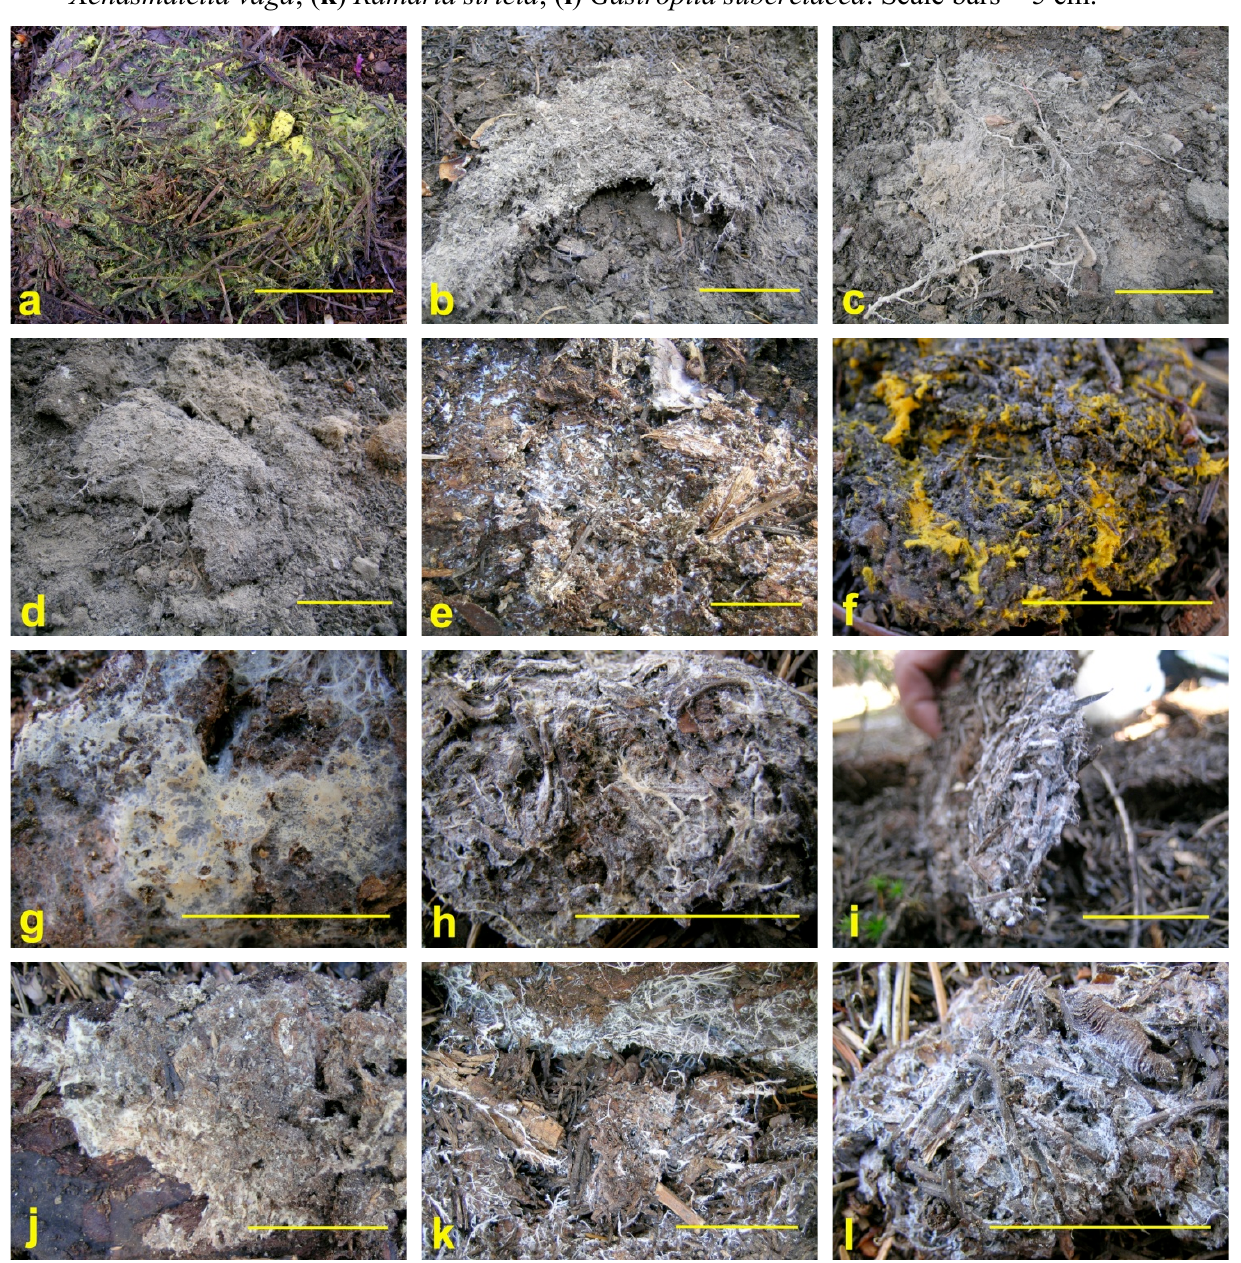
Figure 1. Fungal mat morphologies. ( a ) Rhizopogon truncatus ; ( b ) Gautieria monticola ; ( c ) Hydnellum peckii ; ( d ) Sistotrema albopallescens ; ( e ) Cortinarius brunneus ; ( f ) Piloderma fallax ; ( g ) Piloderma sp ; ( h ) Rhizopogon salebrosus / subbadius ; ( i ) Trechispora alnicola ; ( j